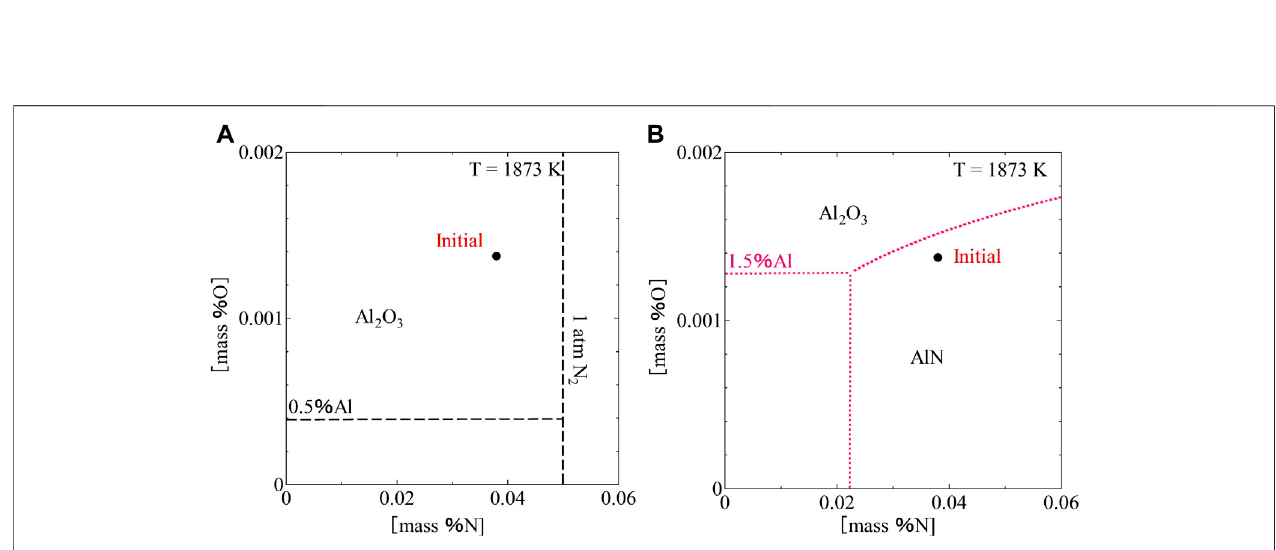
FIGURE 7 | Equilibrium relation between Al 2 O 3 and AlN at (mass %Al) (cid:2) 0.5% (A) , and 1.5% (B) in Fe-Al-2.0Mn system at 1873 K.